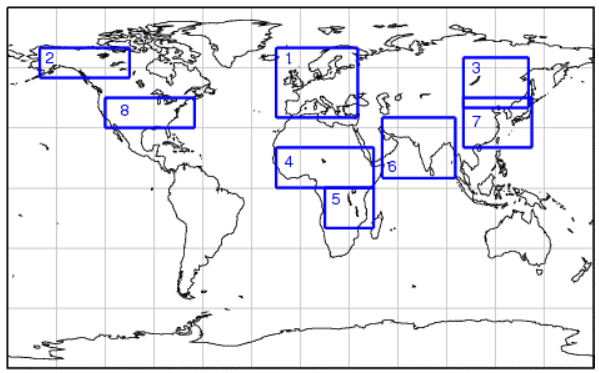
Figure 1. Regions used for regional data stratification in the tro- posphere for the comparison with satellite data. The following re- gions are defined: 1: Europe (15 ◦ W–35 ◦ E, 35–70 ◦ N); 2: